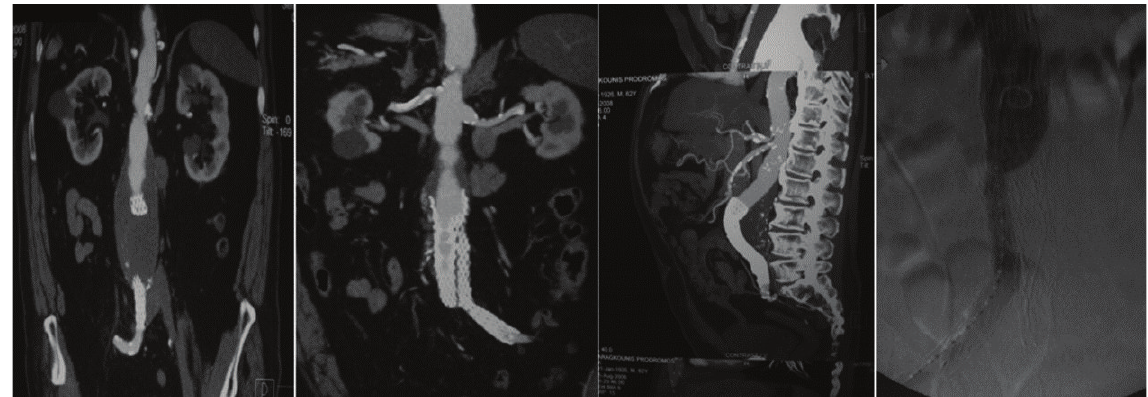
Figure 6: Migration and intense angulation of iliac graft limbs following EVAR, which necessitated the implantation of an aortouniliac stent-graft and a femoral-femoral